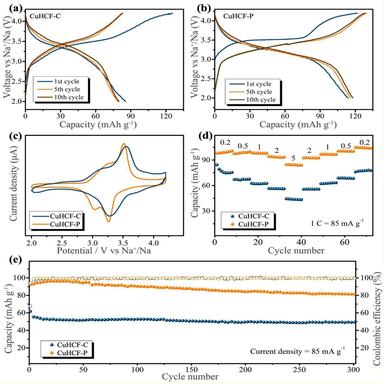
Electrochemical properties. The galvanostatic charge/discharge curves of (a) CuHCF-C and (b) CuHCF-P at a current of 0.1 C (1 C = 85 mA g−1) for the first 10 cycles. (c) Typical CV curves measured at a scan rate of 0.1 mV s−1, (d) rate performance, and (e) cycling stability of the as-prepared samples.